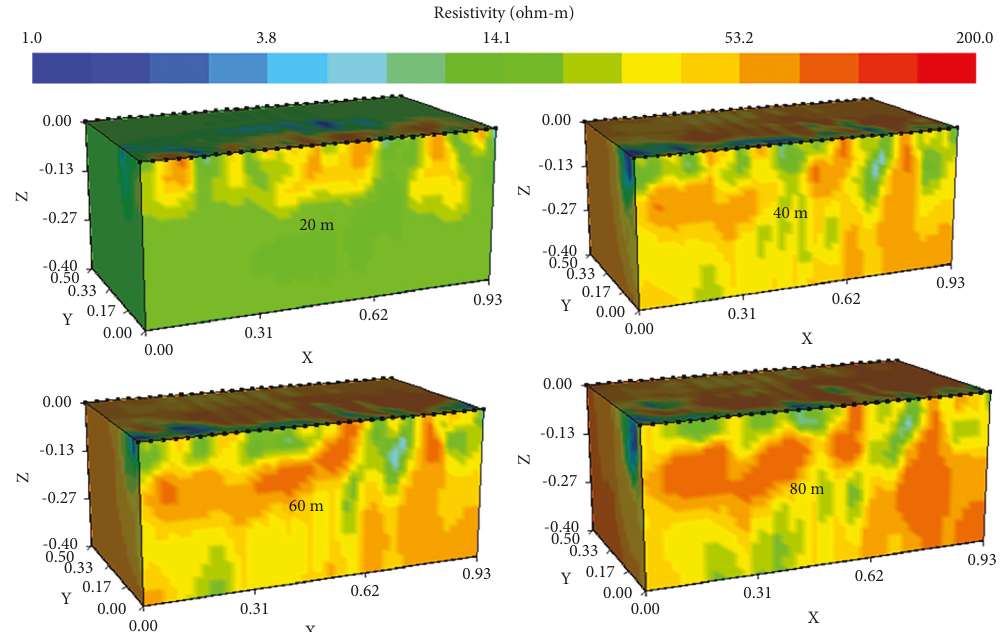
Figure 8: Three-dimensional resistivity inversion map of strata at 40cm above the coal